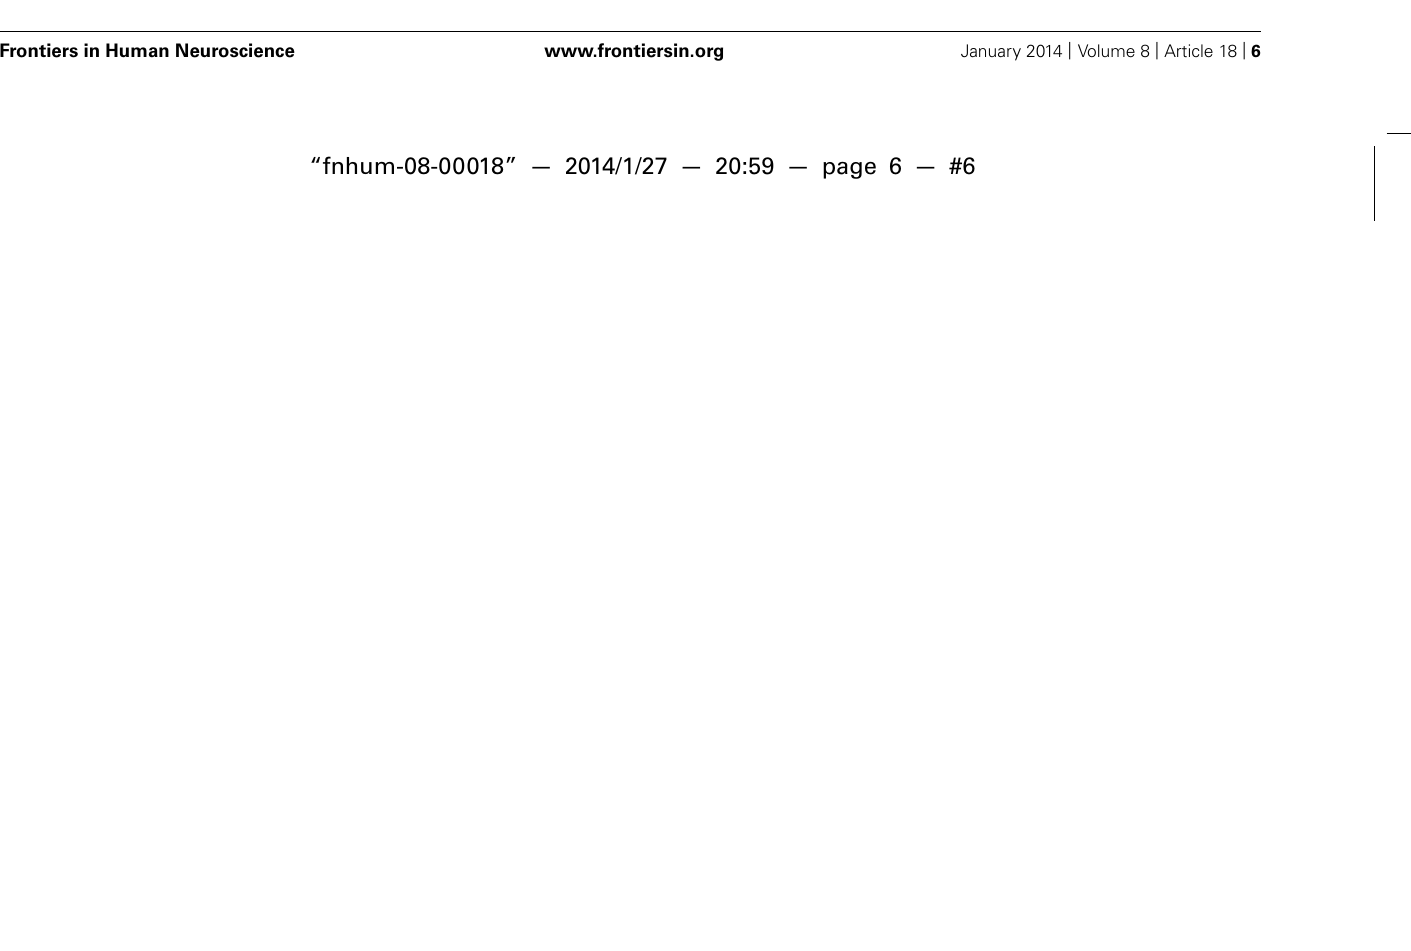
with the peak resel during the scene preview at 486 ms. (B) Areas of the brain and time shift that show above-threshold correlation in activity with the peak resel during the scene preview at 742 ms for all trials. (C) Areas of the brain and time shift that show above-threshold correlation in activity with the peak resel during the scene preview at 742 ms for correct trials